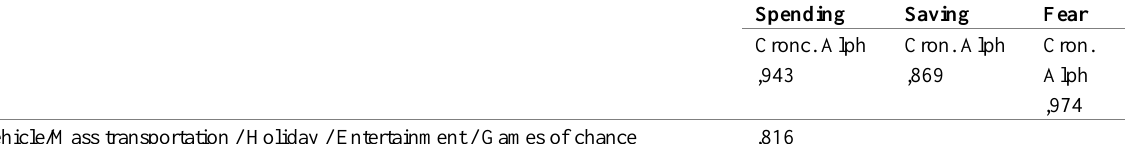
Table 3: T-test Results of Factor Analysis (Scale’s Croanbach’s Alpha:0,934) Coefficients